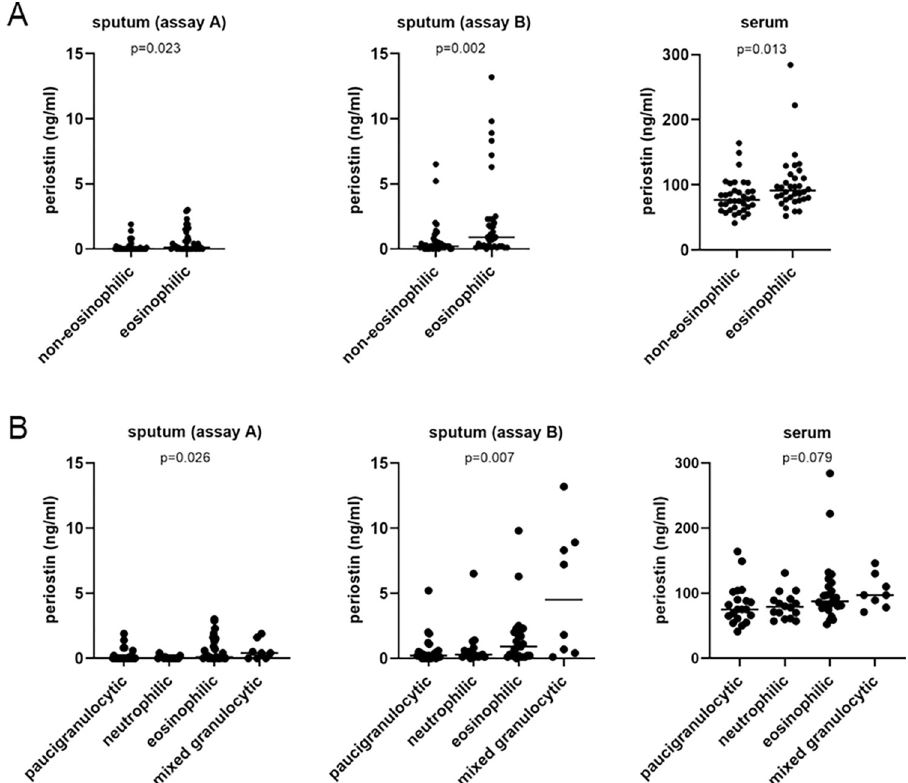
Fig 3. Periostin levels in serum and sputum samples subdivided according to sputum inflammatory profile. Periostin levels were measured in serum and sputum (Assay A and Assay B) in BIOAIR patients and subdivided according to A) sputum eosinophils (eosinophilic = 3% or greater eosinophils, non-eosinophilic below 3% eosinophils) and B) sputum inflammatory profile. Briefly, the four inflammatory profiles were defined as follows: neutrophilic = 61% or greater sputum neutrophils (eosinophils under 3%), eosinophilic = 3% or greater eosinophils (neutrophils under 61%), paucigranulocytic = less than 61% neutrophils and less than 3% eosinophils, and mixed granulocytic = 61% or greater neutrophils and 3% or greater eosinophils. 33% of patients were paucigranulocytic, 21% were neutrophilic, 35.5% were eosinophilic and 10.5% were mixed granulocytic.